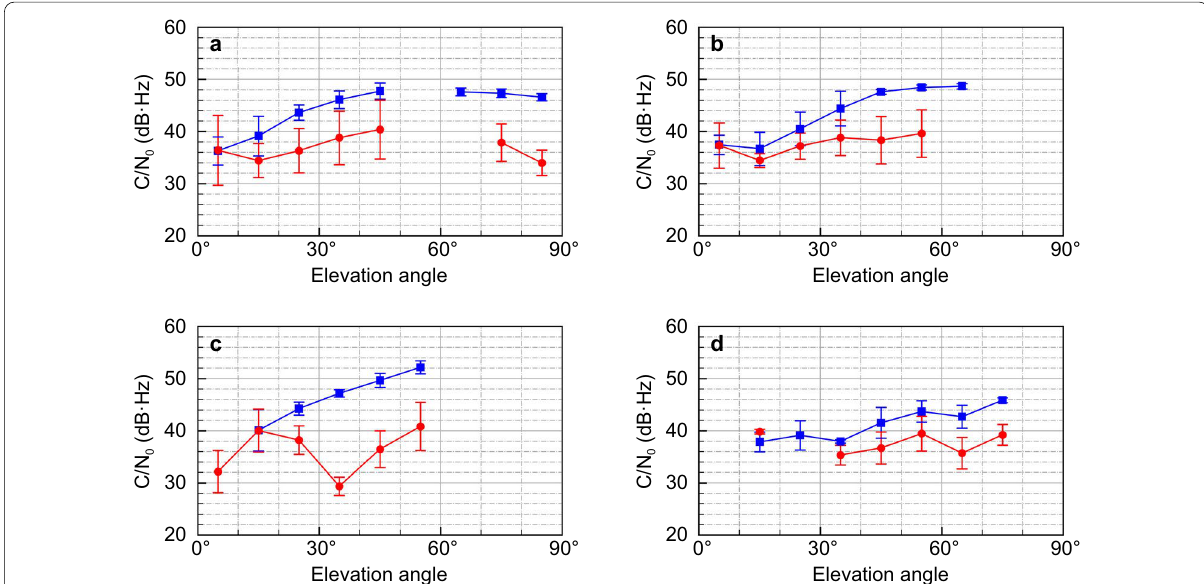
Fig. 9 Averaged carrier-to-noise density ratio (C/N 0 ) with the standard deviation at different elevation angles for GPS in ( a ), GLONASS in (b), Galileo in ( c ), and BDS in ( d ) for the stationary receiver (blue line) and the moving receiver (red line). The error bars around the data points represent the 1σ standard deviation ±